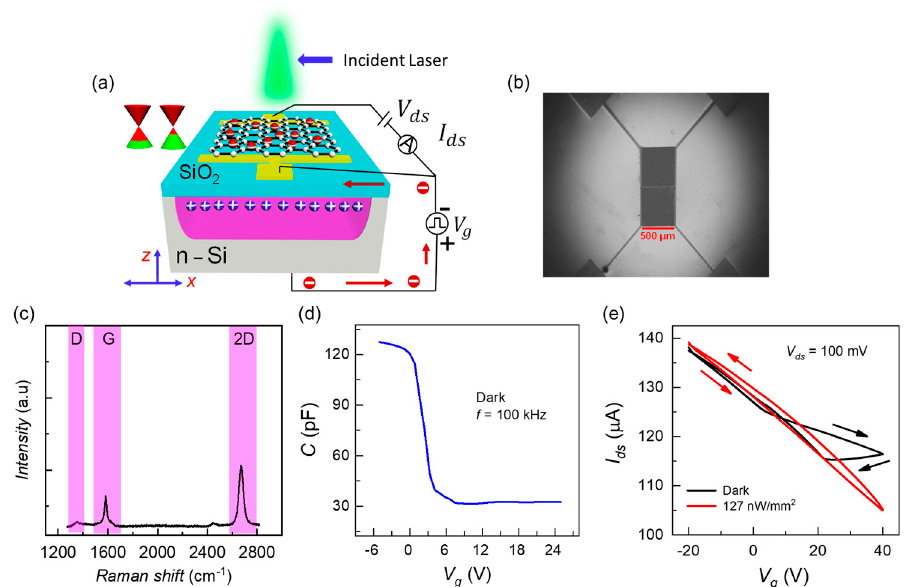
Figure 1. ( a ) A 3D schematic of Gr-Si CCD pixel, electrically connected to measure 𝐼 (cid:3031)(cid:3046) and 𝐼 (cid:3034) . The biasing voltage 𝑉 (cid:3034) and constant voltage source 𝑉 (cid:3031)(cid:3046) are also included. ( b ) The SEM image of the two 500 × 500 µm (cid:2870) area Gr-Si CCD pixels platform. ( c ) The RAMAN spectra characterization shows the implementation of monolayer graphene as 𝐼 (cid:2870)(cid:3005) 𝐼 (cid:3008) ⁄ (cid:3408) 2 . ( d ) The quasi-static C-V measurement at 100 kHz modulation frequency in the dark scenario. ( e ) By quasi-statically sweeping the voltage 𝑉 (cid:3034) , the contribution of Si/SiO (cid:2870) and graphene/SiO (cid:2870) trapping states on hysteresis through ( 𝐼 (cid:3031)(cid:3046) − 𝑉 (cid:3034) ) are observed within the operating voltages of the work. Both the forward and backward scans in the dark (black arrows) and under illumination (red arrows) are plotted.